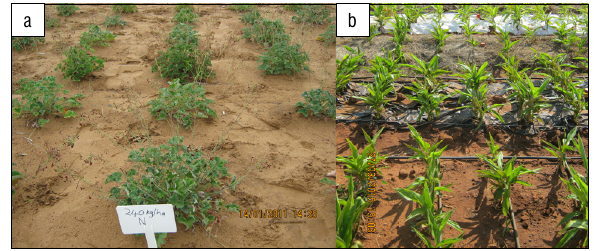
Figure 2: Cultivation research: (a) fertiliser application trials on Pelargonium sidoides and (b) mulching trials on Siphonochilus aethiopicus . Additionally, in vitro cloned and greenhouse-acclimatised P. sidoides plants retained their phytochemical composition, based on phenolic compound profiling. 69 Greenhouse-grown, tissue-culture-derived tubers